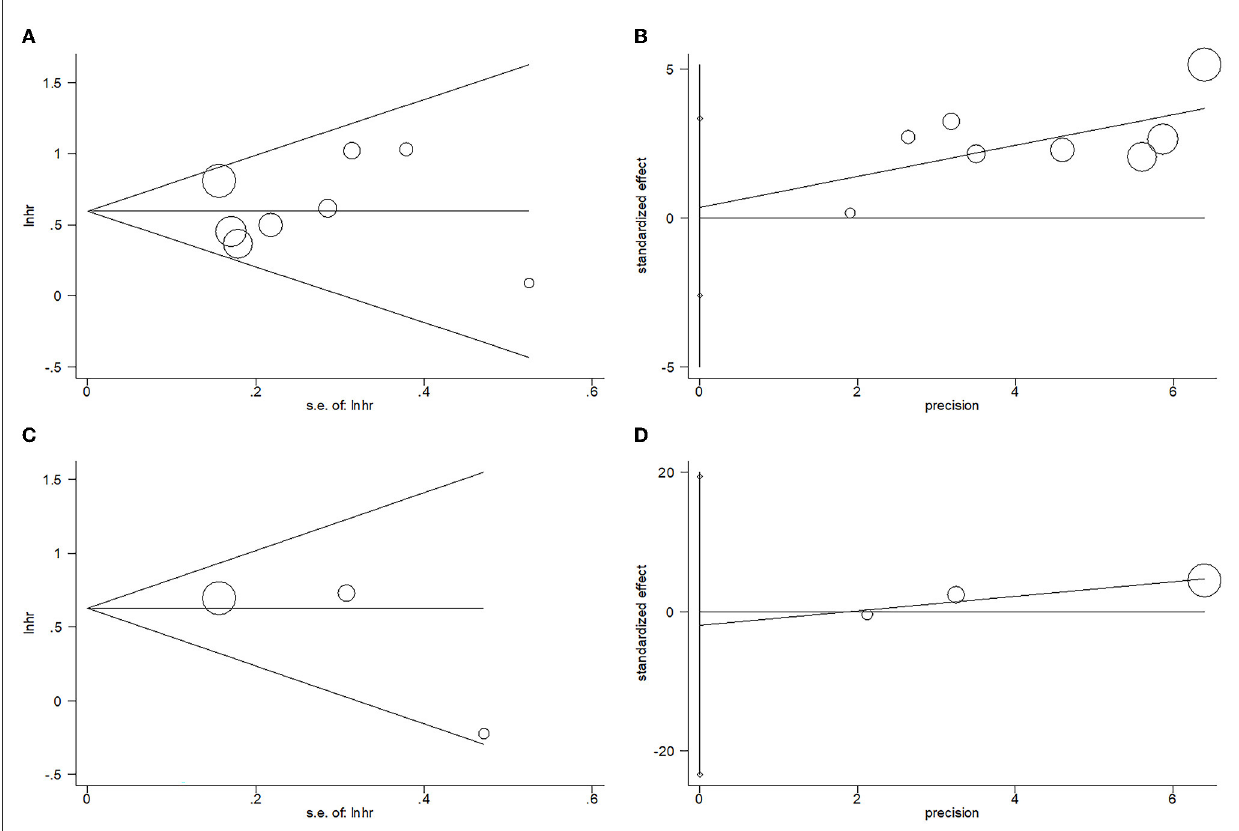
FIGURE5 Results of the analysis of publication bias. (A) OS, Begg’s test, p = 1; (B) OS, Egger’s test, p = 0.776; (C) PFS, Begg’s test, p = 0.296; and (D) PFS, Egger’s test, p =